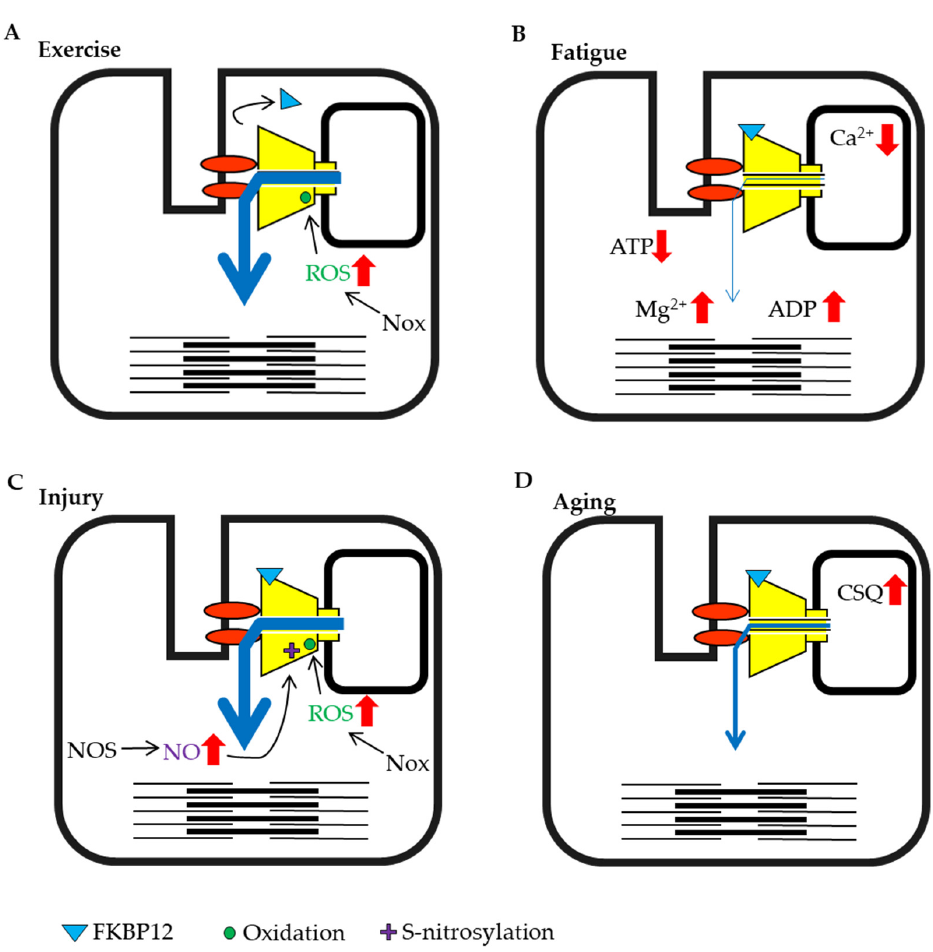
Figure 2. Schematic representation of skeletal muscle ryanodine receptor (RyR1) modulation by intracellular factors under different conditions. ( A ) Exercise training by eccentric contraction. ( B ) High load bearing work and fatigue. ( C ) Injury condition caused by damage, heat stress or disuse. ( D ) Aging.